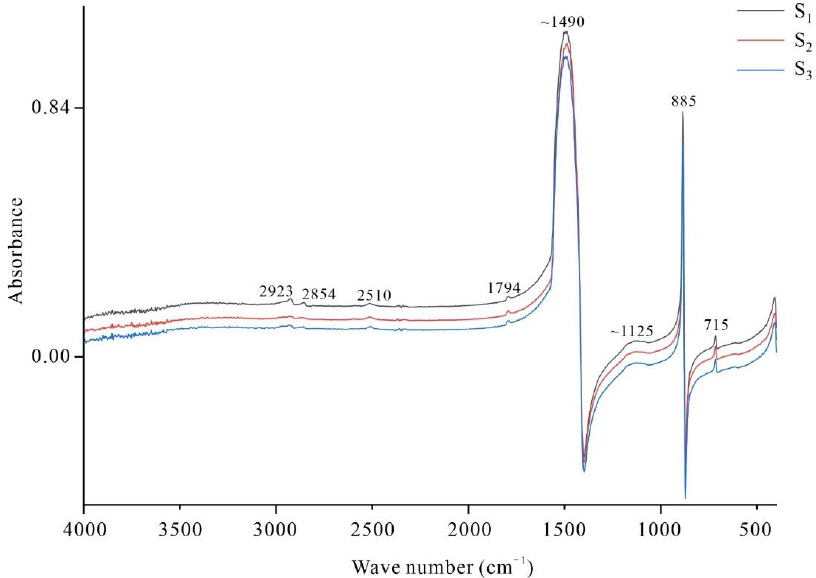
Figure 5. Infrared spectra of three cabochon specimens of Lvwen stone.